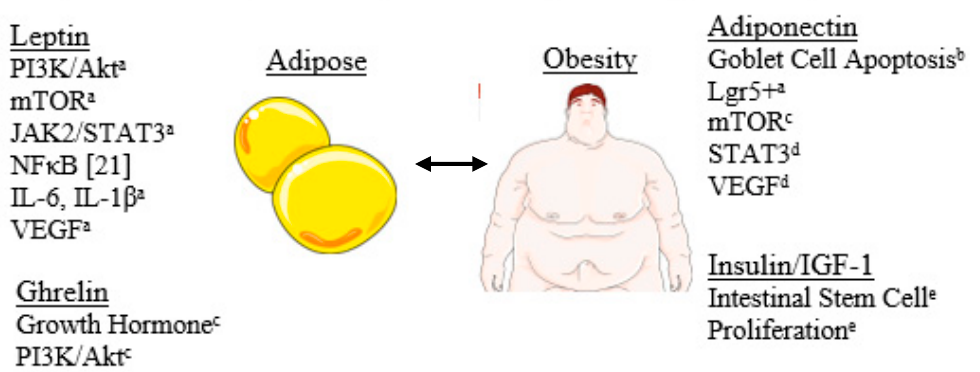
Figure 1. Hormones implicated in obesity, with the respective inflammatory cytokines and transcrip- tion factors they affect. a : Chang et al. 2020, b : Saxena et al. 2013, c : Moodi et al. 2021, d : Moon et al. 2012, e : Pourvali et al. 2021.